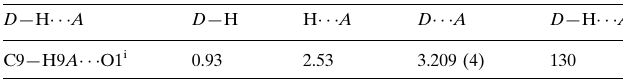
Hydrogen-bond geometry (A˚ , (cid:2)